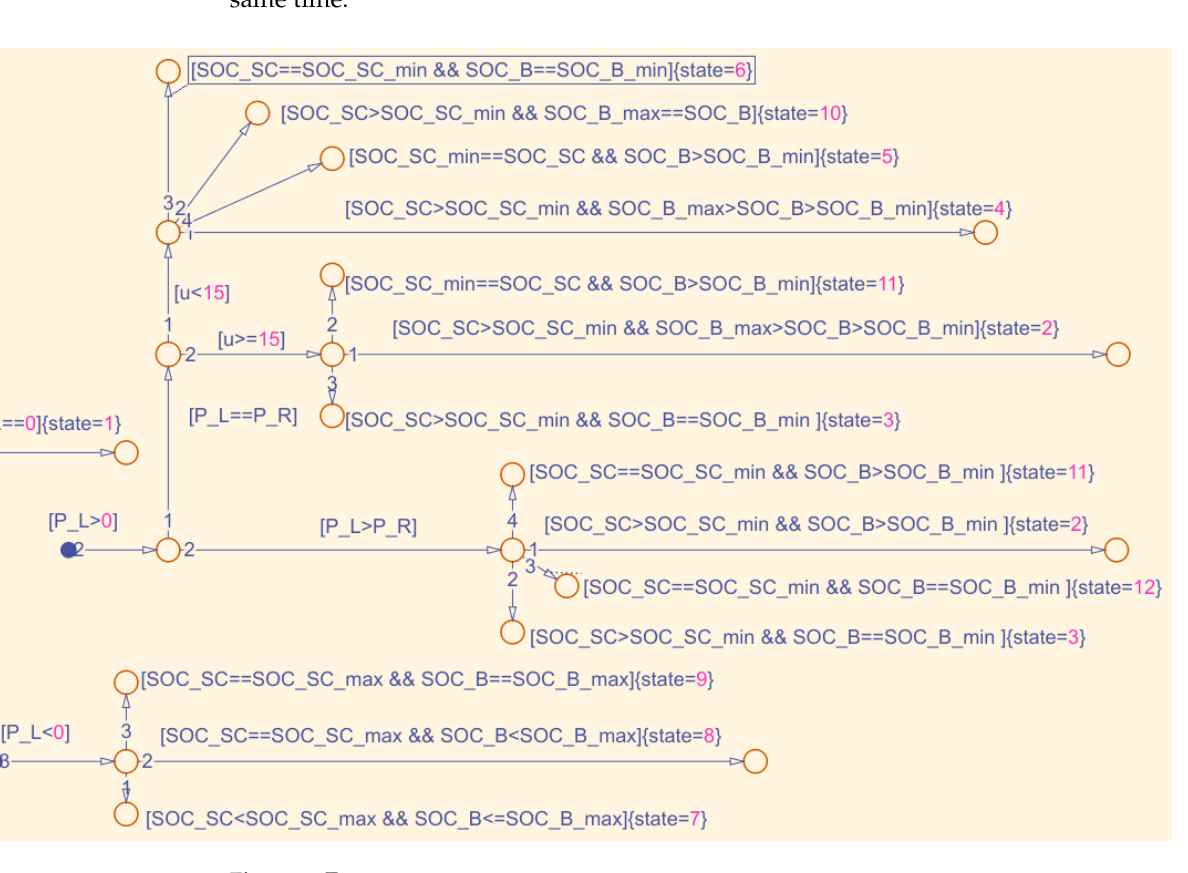
Figure 2. Energy management.